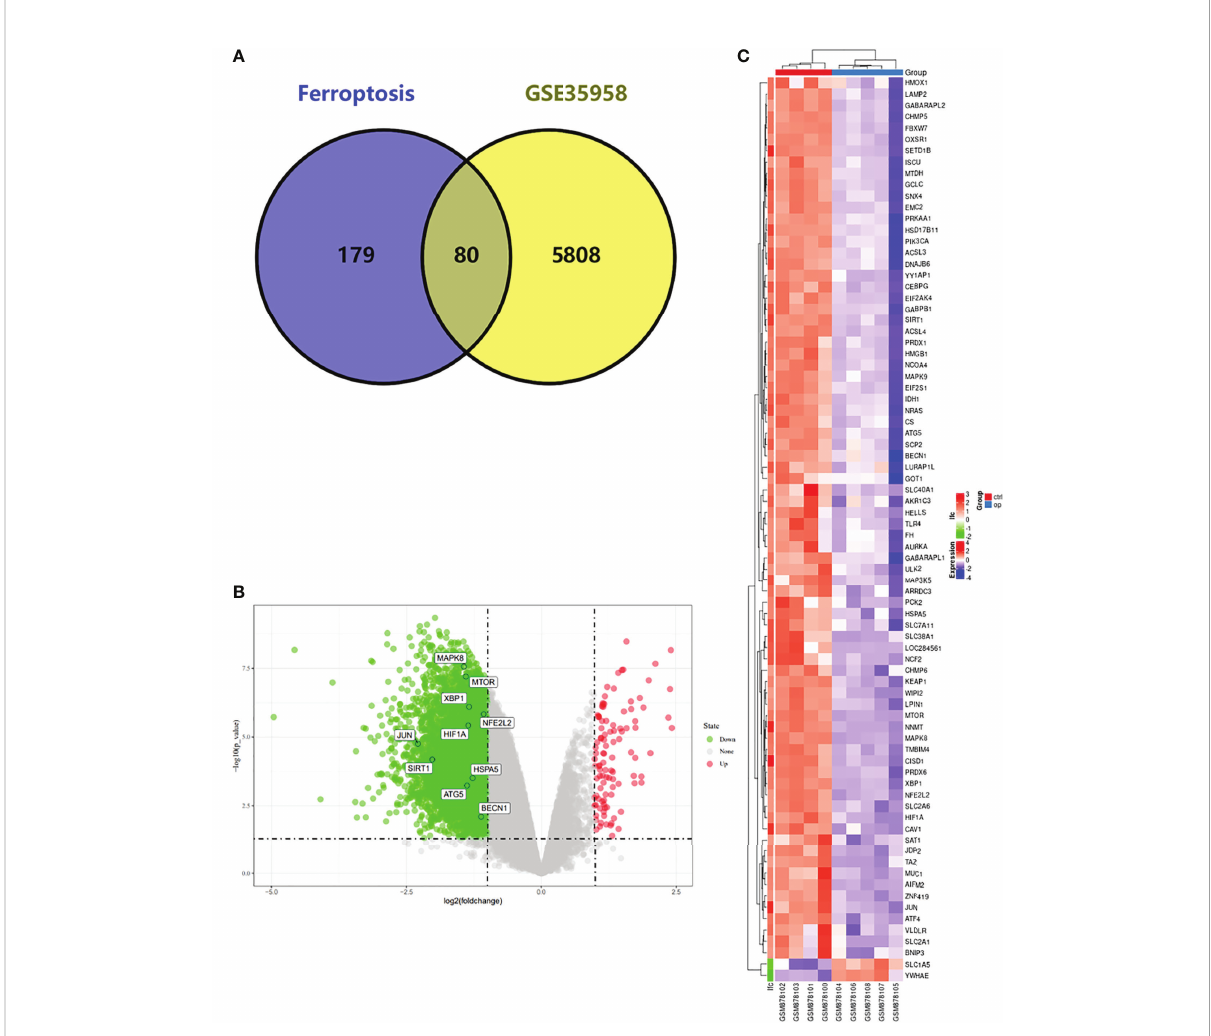
FIGURE 2 Detection of differentially expressed genes (DEGs) in the GSE35958 and Identi fi cation of shared DEGs with ferroptosis. (A) Venn diagram of DEGs in ferroptosis and GSE35958. (B) Volcano map of GSE35958, red represent up-regulated genes and green represent down-regulated genes, The top 10 genes identi fi ed by CytoHubba were marked in the diagram. (C) An expression heat map of the 80 Ferr-DEGs in GSE35958